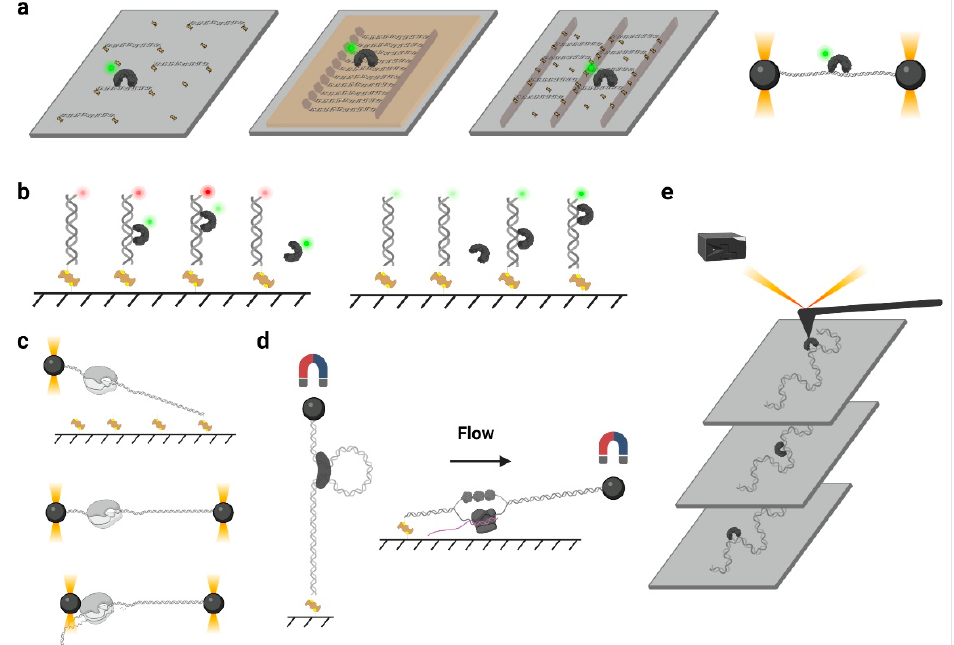
Figure 2. Single-molecule methods for observing protein 1D sliding. ( a ) An illustration of tracking a single protein molecule on DNA using TIRF or confocal microscopy. Four types of DNA immobilization methods are shown, including random immobilization, DNA curtains, DNA skybridges, and C-trap optical tweezers (from left to right). The gray rectangles represent the quartz surfaces and the yellow rectangle represents the lipid bilayers. The black spheres represent the dielectric beads. The fluorophore-labeled proteins (DNA-binding proteins with green dyes) on DNA are shown. ( b ) An illustration of monitoring the distance between DNA and protein using FRET (left) and PIFE (right). The fluorophore-labeled DNA substrates are immobilized on quartz slide surfaces. The DNA-binding proteins slide on DNA and cause FRET (left) or PIFE (right). ( c ) An illustration of detecting the forces associated with DNA–protein interactions using optical tweezers. Three types of experiment designs are shown, including surface-base assay, dumbbell-based assay using two optical traps to tether DNA double ends, and dumbbell-based assay using two optical traps to tether the DNA end and protein, respectively (from top to bottom). The black spheres represent the dielectric beads. ( d ) An illustration of detecting the forces associated with DNA–protein interactions using magnetic tweezers. A general set up (left) and a flow stretching set up (right) are shown. The black spheres represent the superparamagnetic beads. ( e ) An illustration of imaging the different states of DNA–protein interactions over time using AFM. The black box represents the detector which monitors the cantilever deflection.